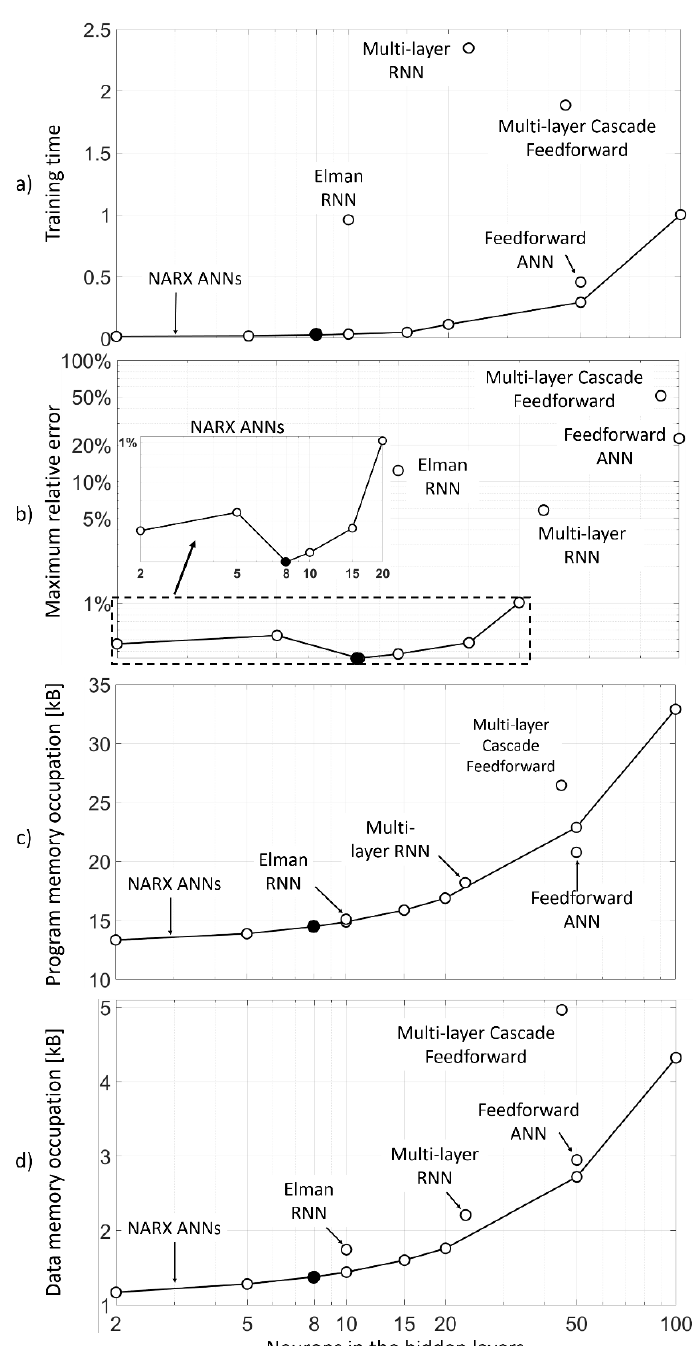
Figure 8. Comparison of all the proposed architectures. ( a ) Training time normalized with respect to the 100 Neurons NARX. ( b ) Maximum Relative Error (MRE) of estimation. ( c ) Computational cost: program memory occupation. ( d ) Computational cost: data memory occupation. The black circle indicates the ANN with the best performance: NARX single layer, eight neurons.